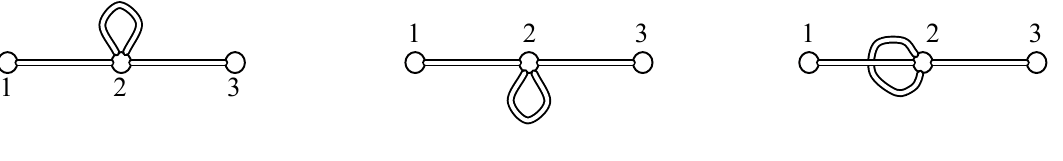
Figure 2 . Graphs forming the set G 0 ; 3 (1 ; 4 ; 1)